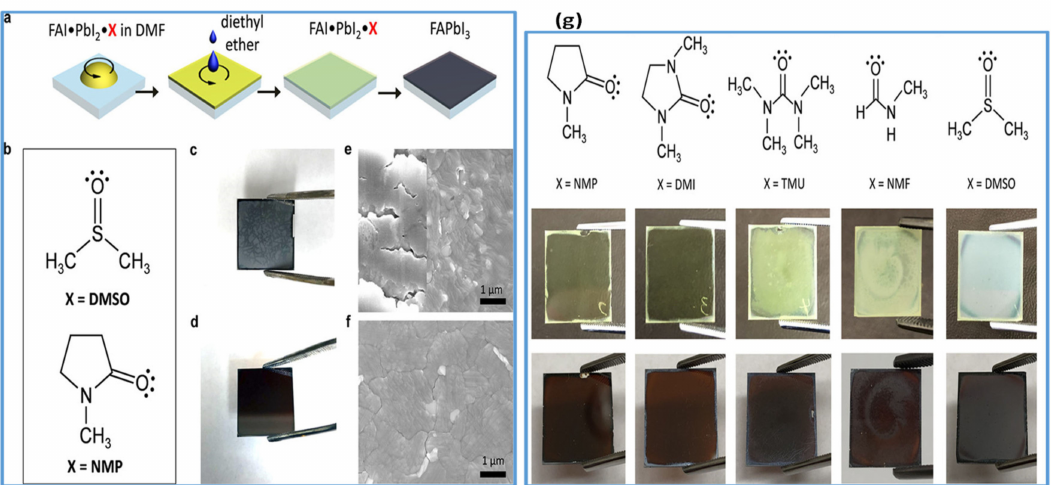
Figure 5. ( a ) Represents the fabrication of FAPbI 3 perovskite films by a Lewis base adduct approach. ( b ) Represents the molecular structure of Lewis bases: dimethyl sulfoxide (DMSO) and N -methyl-2-pyrrolidone (NMP). ( c – f ) Photographs and SEM images of theFAPbI 3 perovskite films. ( g ). Molecular structures of the Lewis bases used in theFAPbI 3 perovskite films (upper panel) Lewis bases perovskite adducts (middle panel) and the crystallized perovskite films (lower panel). Reproduced with permission from ref. [109], Copyright 2018, Journal of the American Chemical Society